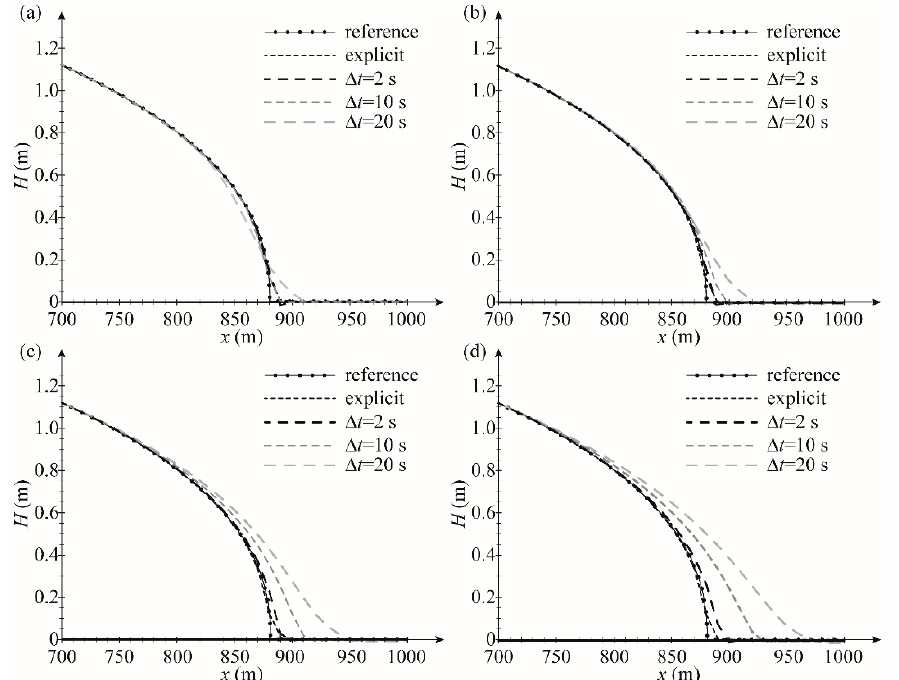
Figure 5. Numerical solution of Equation (4) at t = 450 s with ∆ x = 10 m using the explicit scheme ( ∆ t = 0.017 s) and the implicit scheme for various time step values ∆ t = [2, 10, 20] s and for various values of the weighting parameter: θ = 0.5 ( a ), θ = 0.6 ( b ), θ = 0.8 ( c ), θ = 1.0 ( d ).